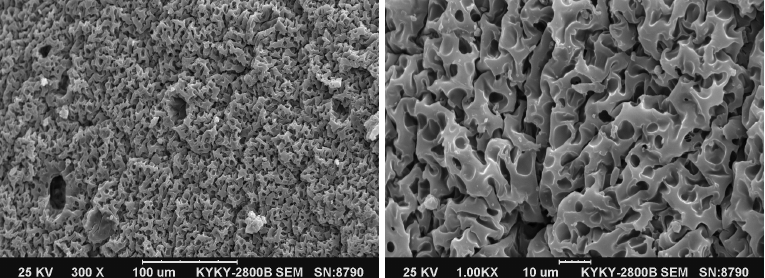
Figure 1. SEM photographs of the carrier, 300 × and 1,000 × magnification. Table 1. The immobilization results of β -galactosidase on the